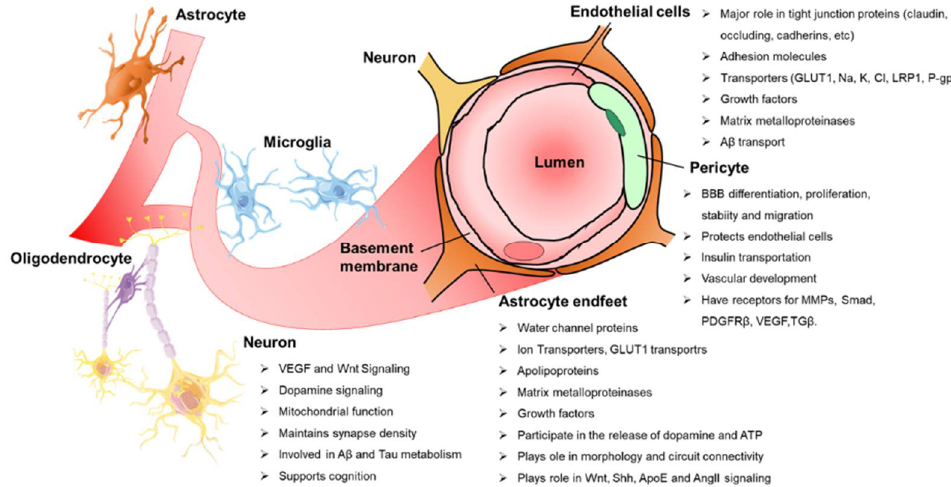
Figure 1. The cellular and molecular components required for BBB formation, maintenance, and function. Pericytes, endothelial cells, astrocytes, neurons, and microglia make up the neurovascular unit. Pericytes share a common basement membrane with the endothelium and connect with several transmembrane junction proteins. Low-level bulk-flow transcytosis and tight junction and adherens junction proteins between endothelial cells maintain the BBB integrity. Astrocytes connect with pericytes, endothelial cells, and neurons. Microglia regulate immune responses.